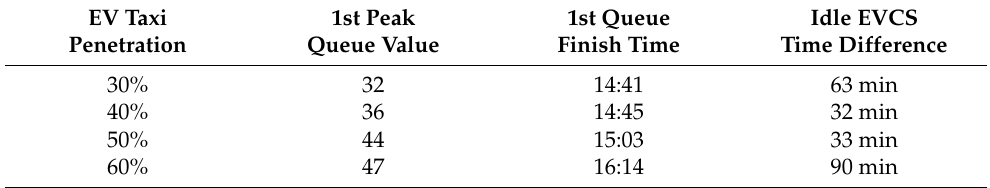
Table 5. Peak number of queuing vehicles, finish queuing time, and idle time difference